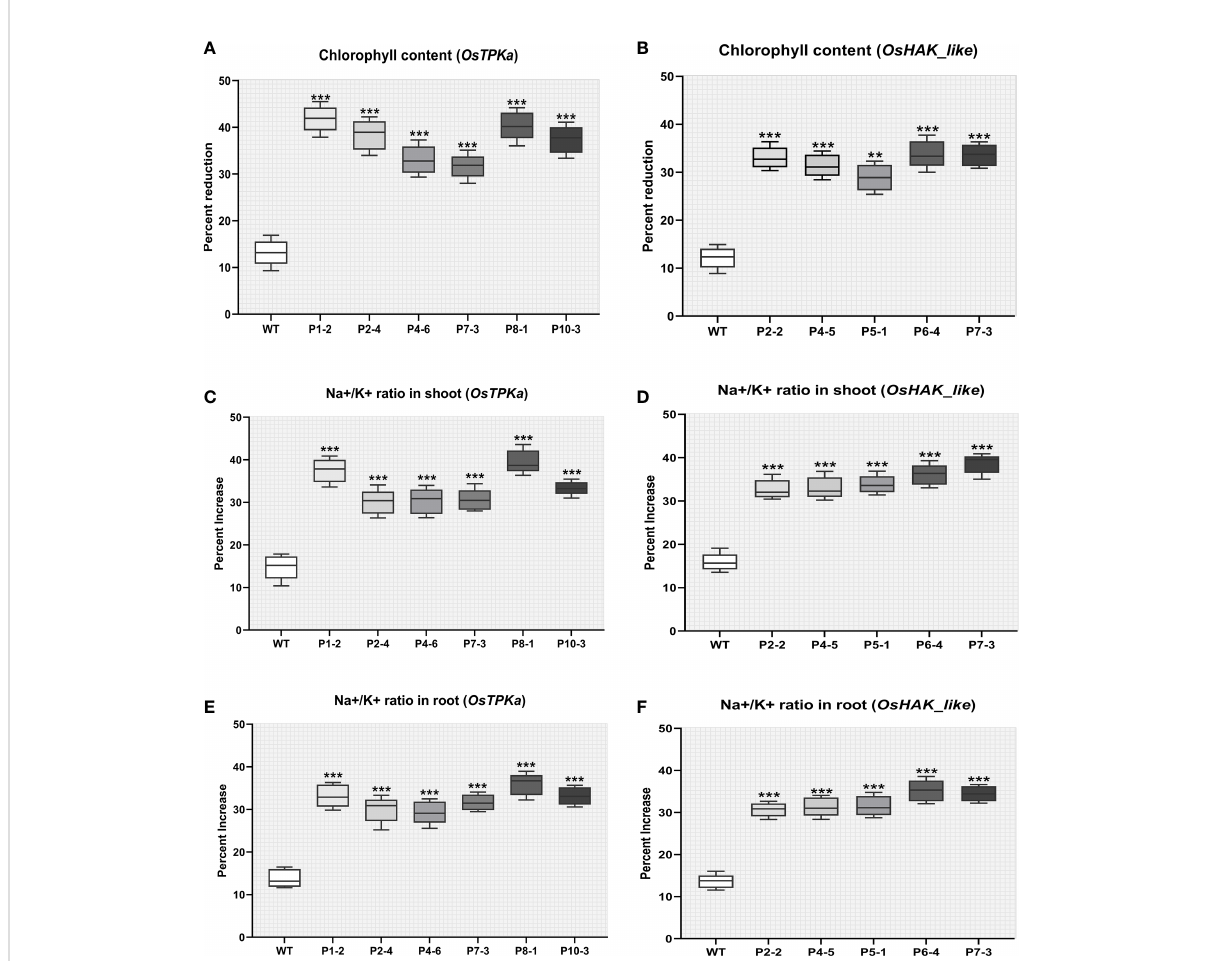
FIGURE 9 Effect of salt stress on phenotypical characteristics of transgenic plants. (A, B) Percent reduction in chlorophyll content; (C, D) Percentage increase in Na + /K + ratio in shoot; (E, F) Percentage increase in Na + /K + ratio in root under 150 mM salt condition. In all the parameters wild type Horkuch performed better compared to sgRNA inserted transgenic lines. The stars in the graph indicates signi fi cant differences (***P < 0.001, **P < 0.01, Ordinary one way ANOVA test).